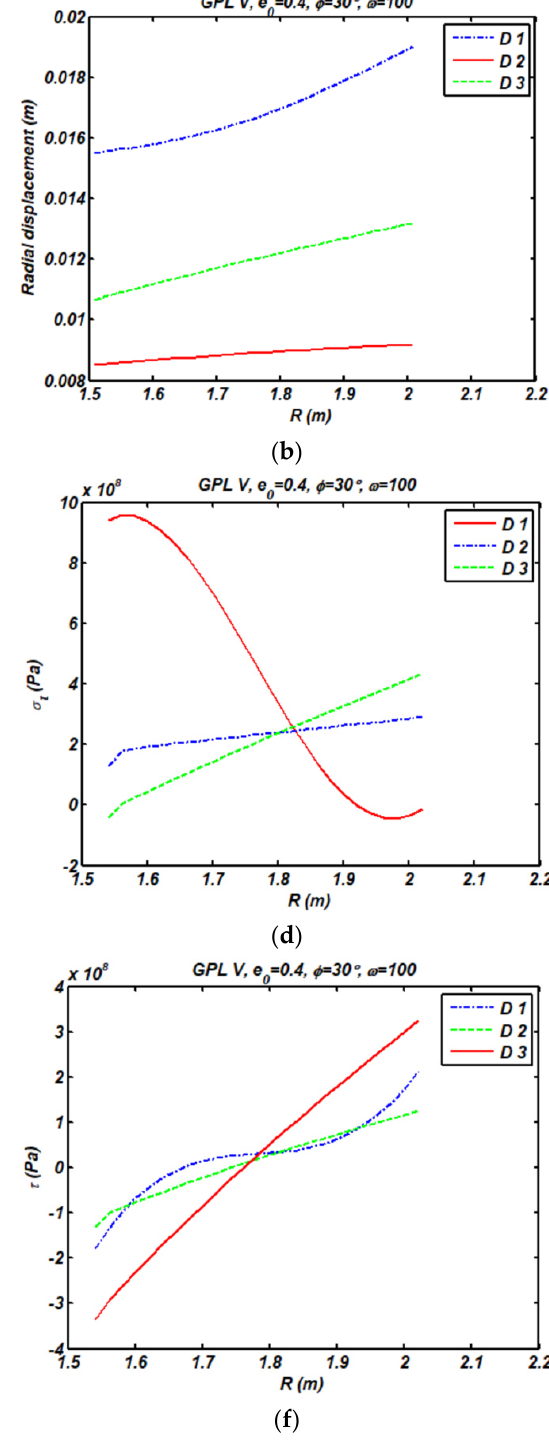
Figure 10. Temperature ( a ), radial displacement ( b ), and stress state ( c – f ) at z = L/2 for various porosity distribution. (GPL V; e 0 = 0.4; φ = 30 ◦ ; γ GPL = 0.01; ω = 100